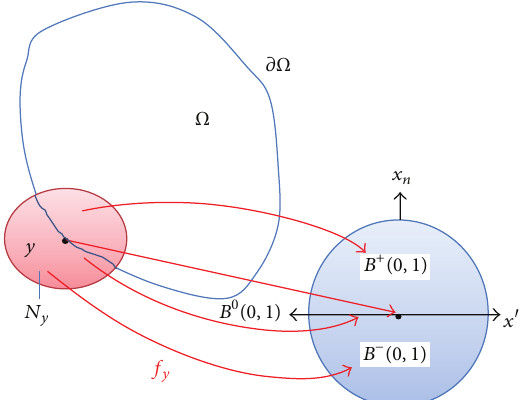
Figure 2: A 𝐶 𝑘,1 -domain Ω , where 𝑓 𝑦 is a diffeomorphism from the neighborhood 𝑁 𝑦 to the ball 𝐵(0,1)